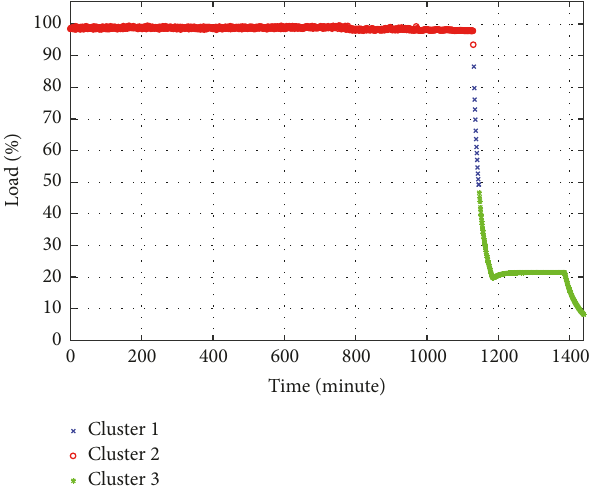
Figure 5: [CS1] Vibration data identified as steady-state (month 1—normal